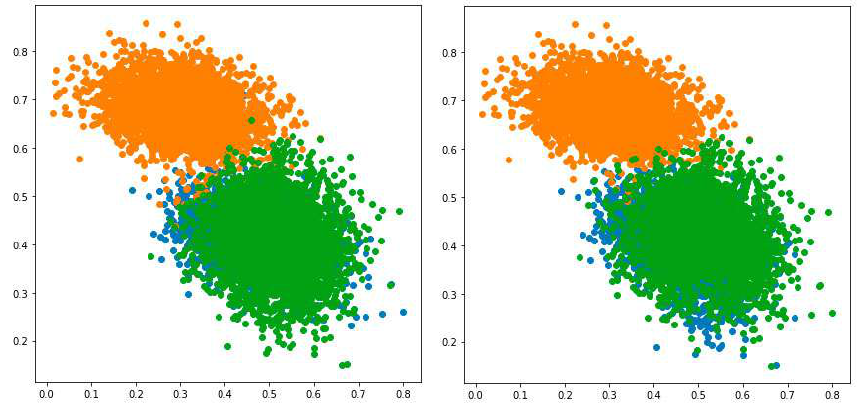
Figure 9. Example of instances from the DS 8 , classified by HPFuzzNDA (the left graph) and PFuzzND (the right graph)